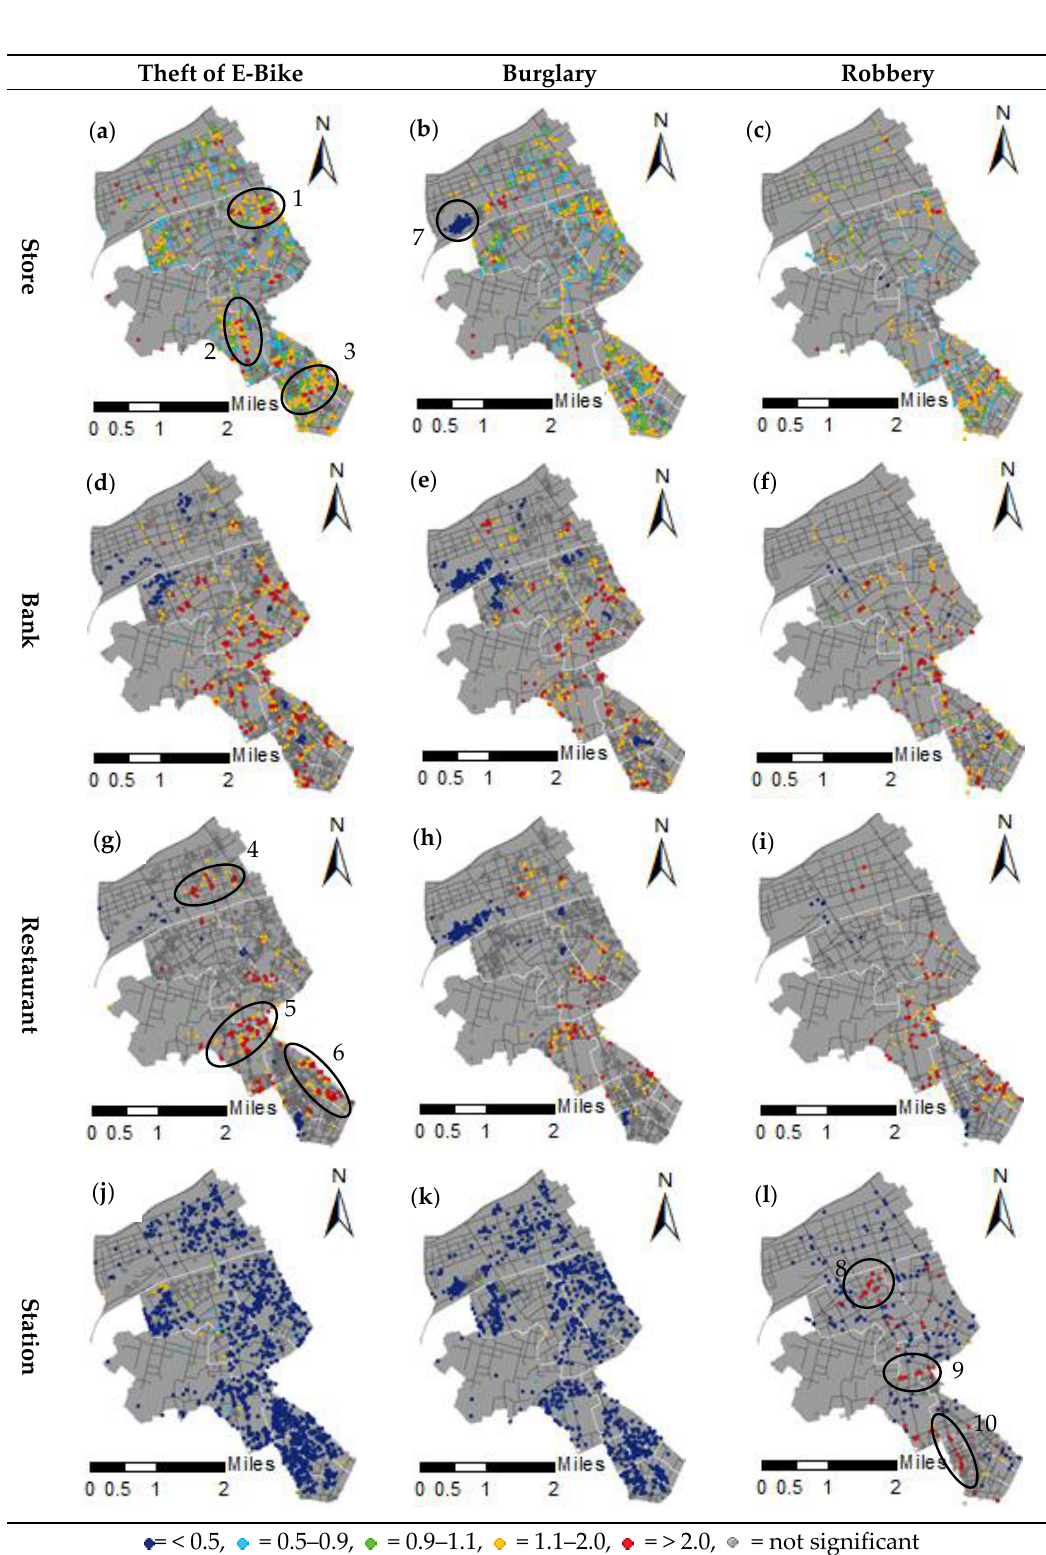
Figure 5. Maps of local colocation patterns of crimes and land-use features for stores, banks, restaurants, and stations: ( a ) theft of e-bike and store; ( b ) burglary and store; ( c ) robbery and store; ( d ) theft of e-bike and bank; ( e ) burglary and bank; ( f ) robbery and bank; ( g ) theft of e-bike and restaurant; ( h ) burglary and restaurant; ( i ) robbery and restaurant; ( j ) theft of e-bike and station; ( k ) burglary and station; ( l ) robbery and station.